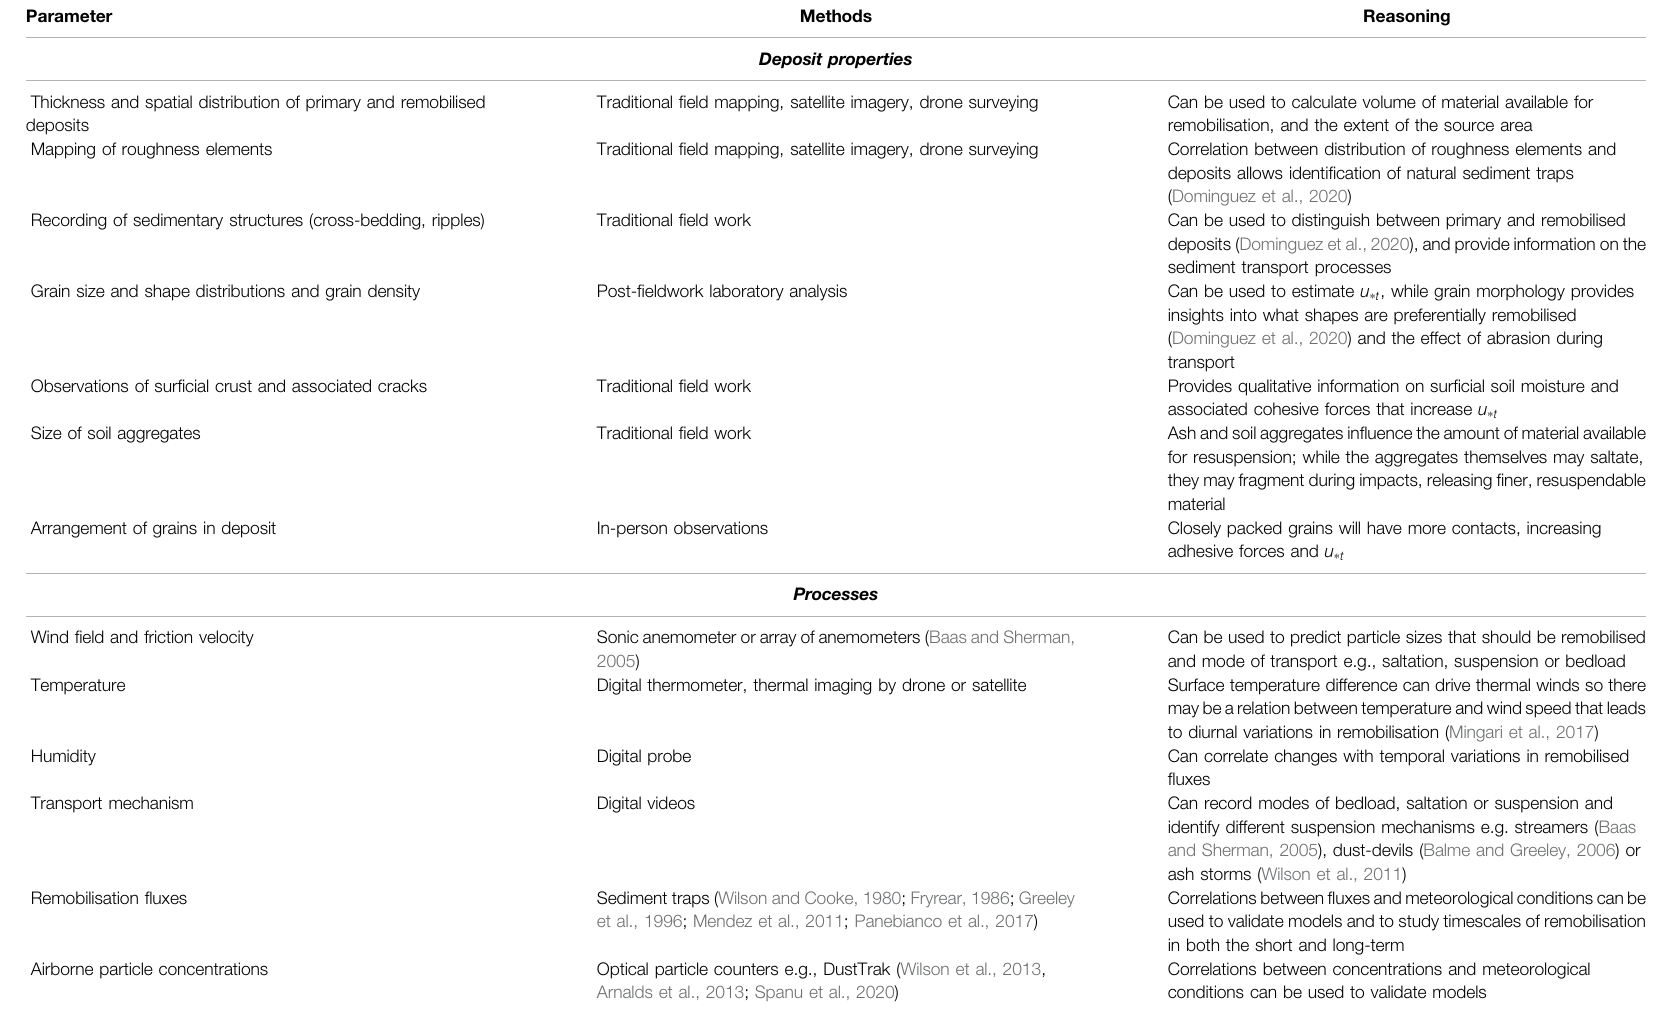
TABLE 1 | Key deposit properties and processes to observe and measure in the fi eld in order to characterise ash